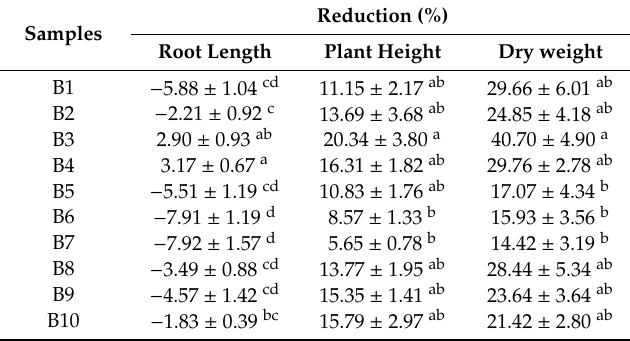
Table 4. Reductions in root length, plant height, and dry weight caused by salinity stress.